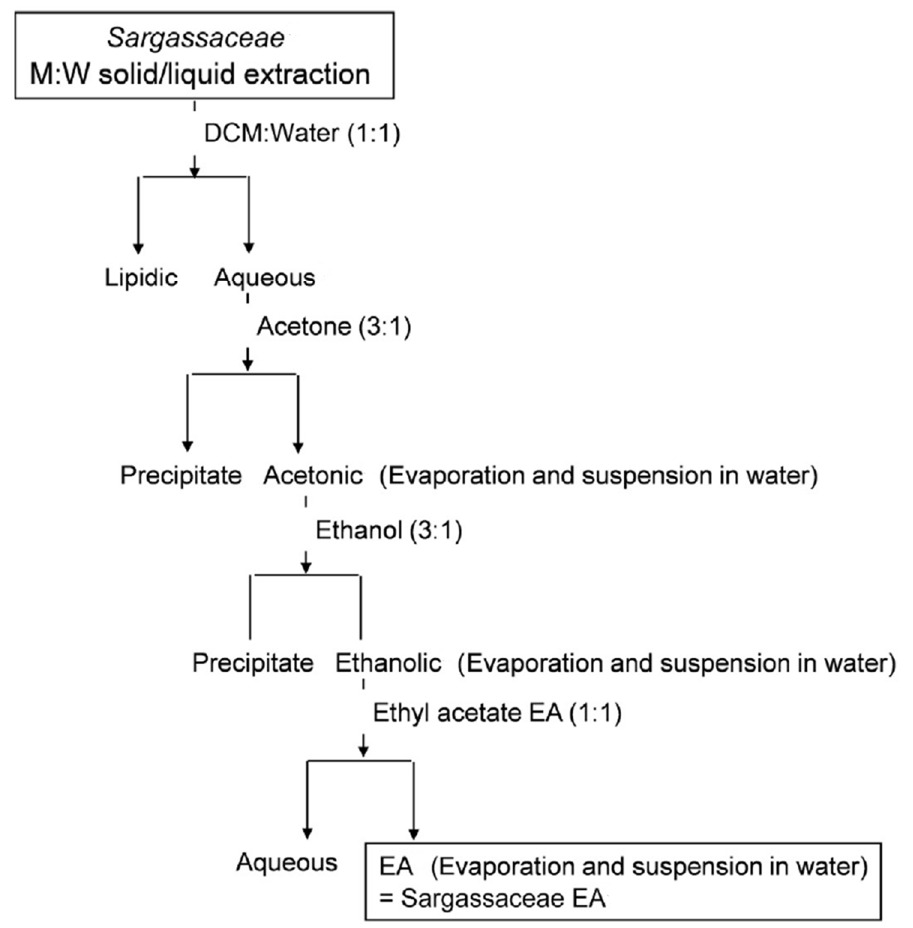
Figure 17. Procedure of liquid–liquid extraction of phenolic compounds from Sargassaceae spp. [209]. M:W: methanol:water; DCM: dichloromethane.